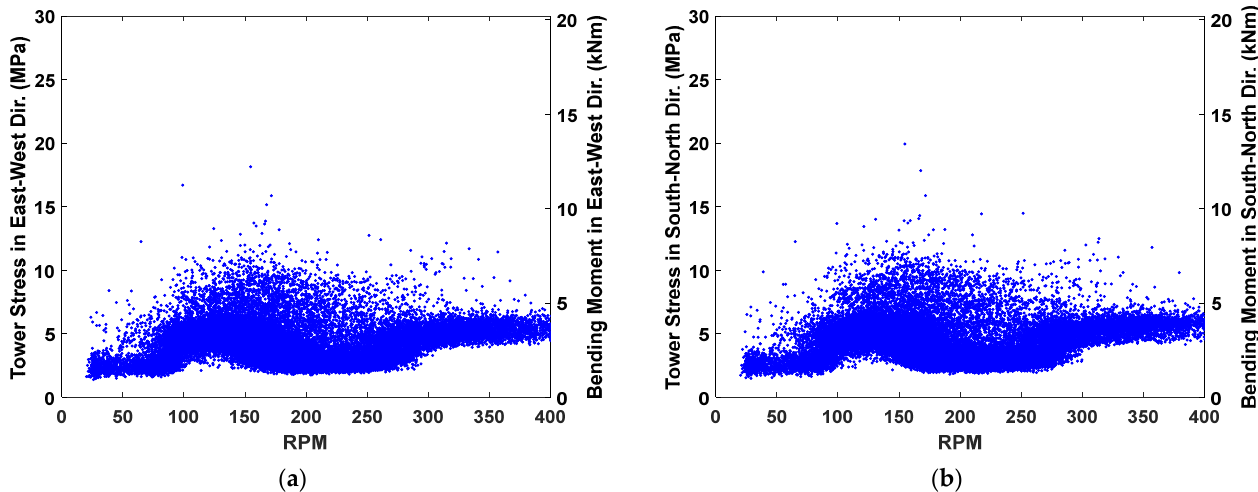
Figure 9. Measured tower bending stress (left axis) for each 1-min data set and the corresponding bending moment (right axis): ( a ) bending stress and moment in the east—west direction, σ EW ; ( b ) bending stress and moment in the south—north direction, σ SN